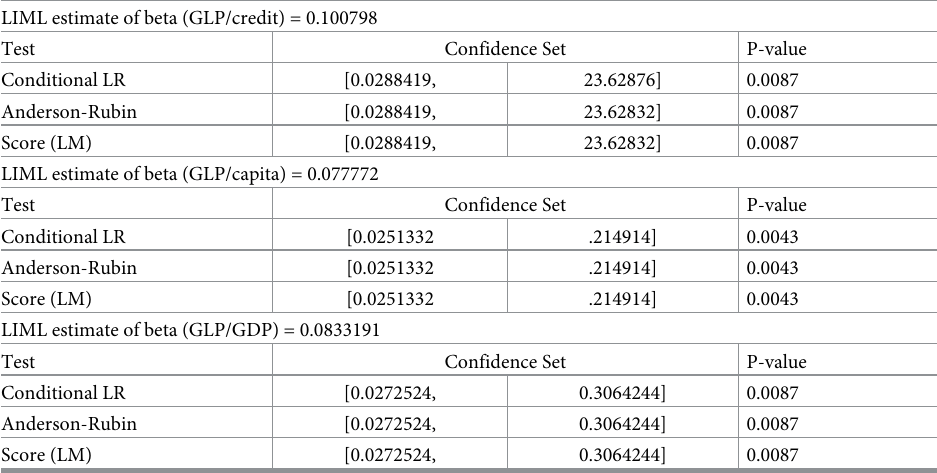
Table 7. Weak instrument-robust 2SLS (dependent: Distrust poor). LIML estimate of beta (GLP/credit) = 0.100798 Test Confidence